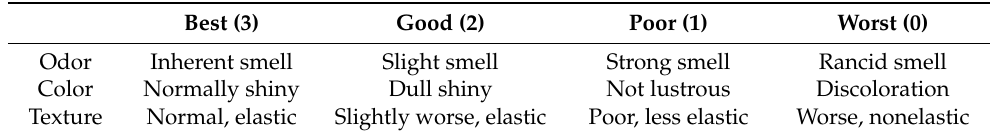
Table 1. Standards of sensory